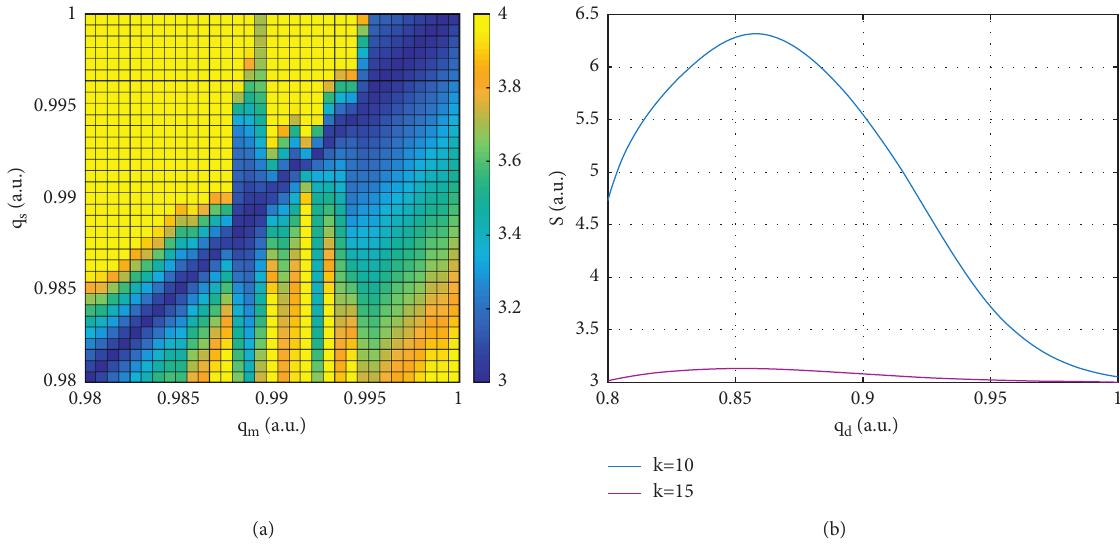
Figure 6: (a) Synchronization map as a function of integration orders q and considering a fixed integration order of q d � 0 . 985 in the dynamic coupling. (b) Synchronization map for system equations (18)–(20) as a function of the integration order q d of the dynamic coupling, while considering that the master and slave oscillators have fixed integer order, i.e., q �